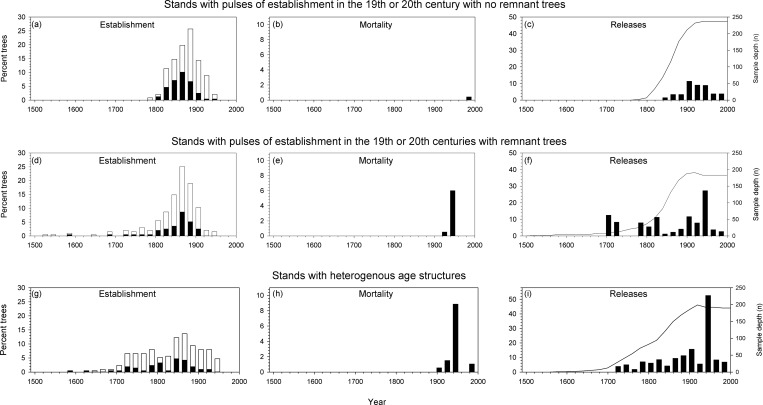
Stand disturbance histories.Dates of establishment expressed as a percentage of total trees established (black bars represent pith or estimated pith dates and gray bars represent minimum ages), mortality expressed as a percentage of total trees alive at the time (last complete year of growth), and releases expressed as a percentage of total trees alive at the time (abrupt > 200% increases in ring-width growth sustained > 10 years) of trees in 20 year bins in (a-c) stands characterized by a pulse of establishment in the 19th or 20th century with no remnant trees, data aggregated from 11 stands; (d-f) stands characterized by a pulse of establishment in the 19th or 20th centuries with remnant trees, data aggregated from 9 stands; and (g-i) stands characterized by heterogeneous age structures, data aggregated from 12 stands.